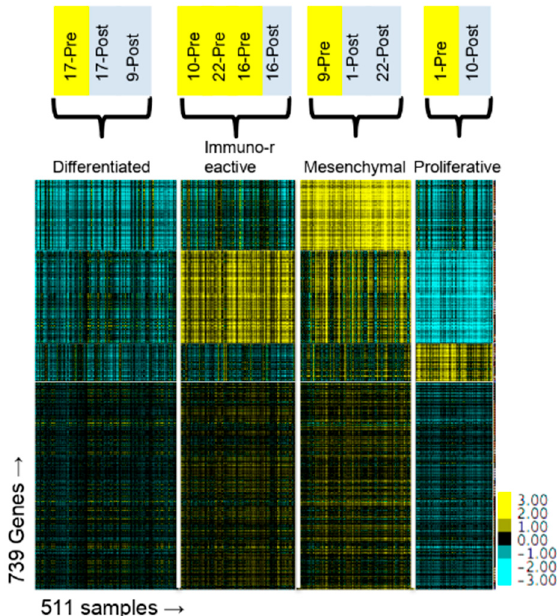
Figure 4. NMF clustering of TCGA, pre-NACT and post-NACT samples. Clustering of NMF target matrix containing combined RNASeq gene expression data from TCGA ( n = 499), pre-NACT ( n = 6) and post-NACT ( n = 6) samples (k = 4). TCGA molecular subtype name is indicated at the top of the heat map. Pre- and Post-NACT sample molecular group assignment is indicated at the top of the heat map. Table 3. Hallmark gene sets enriched in pre-NACT Table 2. Molecular subtype assignment.